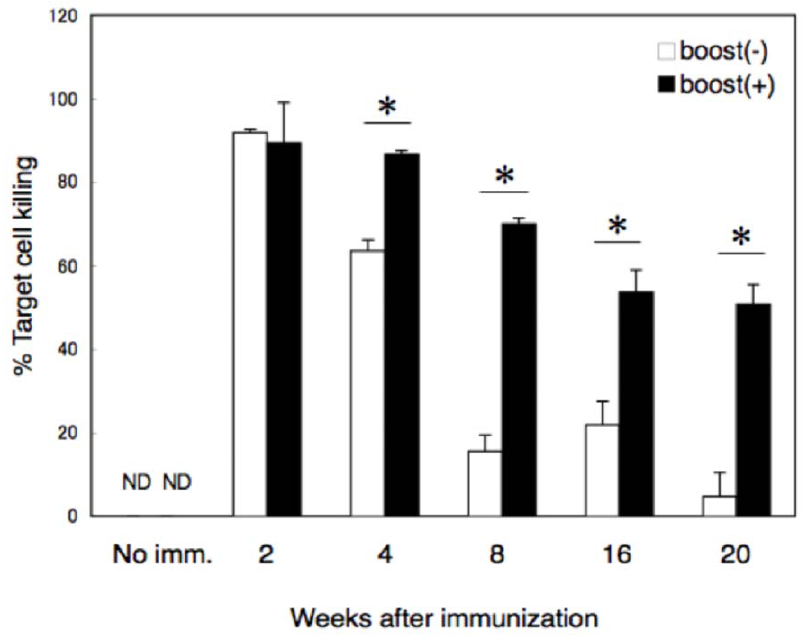
Figure 3. Secondary CTL response in mice immunized with OVA 257-264 -liposome. Mice were immunized with 50 m l of OVA 257-264 -liposome in the presence of 5 m g CpG, and 2, 4, 8, 16, and 20 weeks later, they received a booster ip injection with 200 m l of 1 mg/ml OVA in PBS (closed box) or no booster injection (open box). Three days after the booster injection, in vivo CTL assay was performed. Data represent mean percentages of cells killed and SEs of three mice per group. ND, not detected. *, significant difference (p . 0.01).